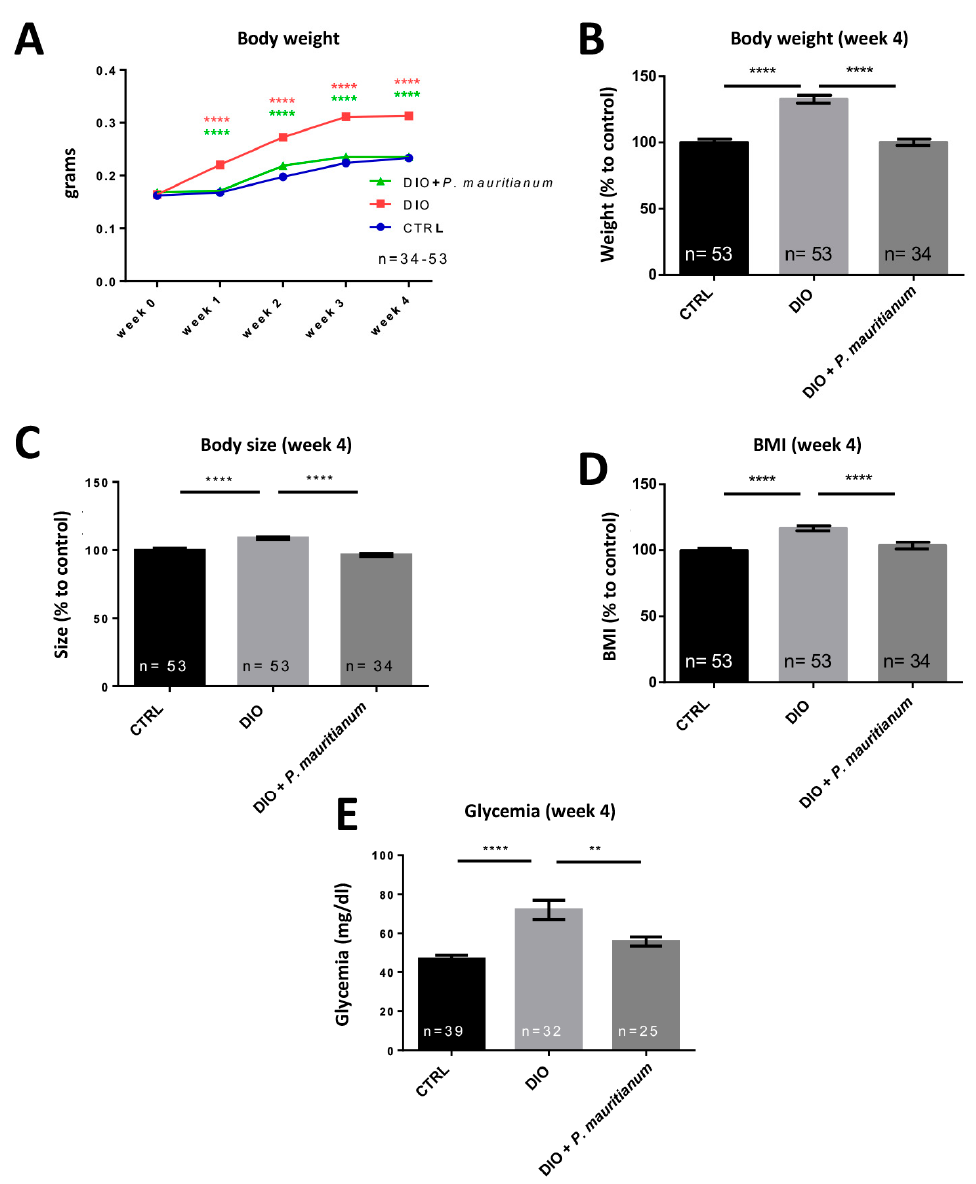
Figure 5. The aqueous extract of P. mauritianum significantly prevents body weight gain, increased BMI and hyperglycemia induced by DIO. ( A ) Line graph showing the increase in body weight during the experiment from week 0 to week 4 in CTRL, DIO and DIO + P. mauritianum (0.25 g/L) groups. ( B – E ) Graphs showing the body weight ( B ), size ( C ), BMI ( D ) and fasting blood glucose ( E ) of CTRL, DIO and DIO + P. mauritianum at the end of the experimental procedure (week 4). All the data result from three independent experiments providing the same results. n = 25–53, number of fish. Bar graph: standard error of the mean (SEM). Two-way ANOVA ( A ); one-way ANOVA ( B – E ): ** p < 0.01; **** p < 0.0001.